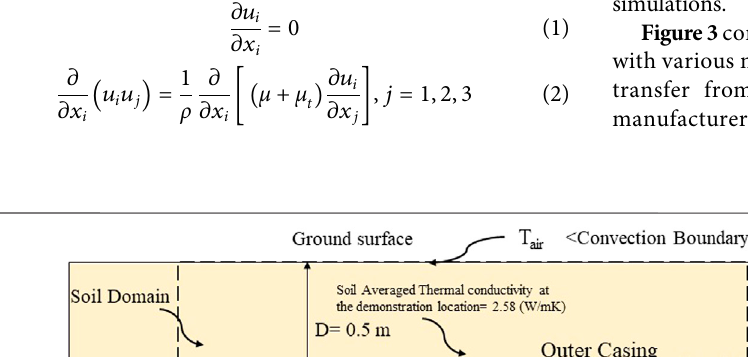
Frontiers in Energy Research |